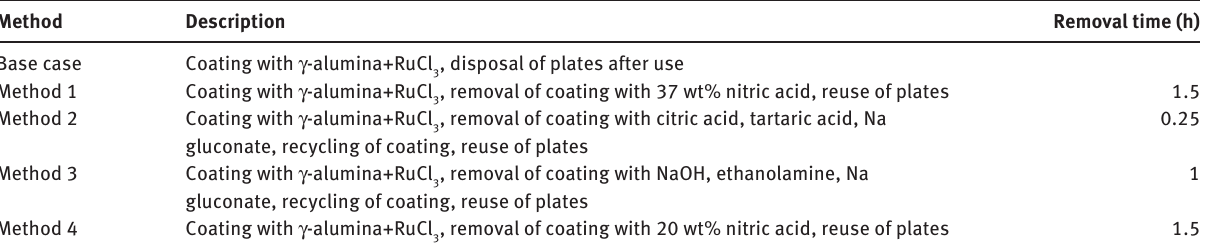
Table 2 Options of treatment of catalytically coated microstructured plates [10] considered for eco-efficiency analysis. Method